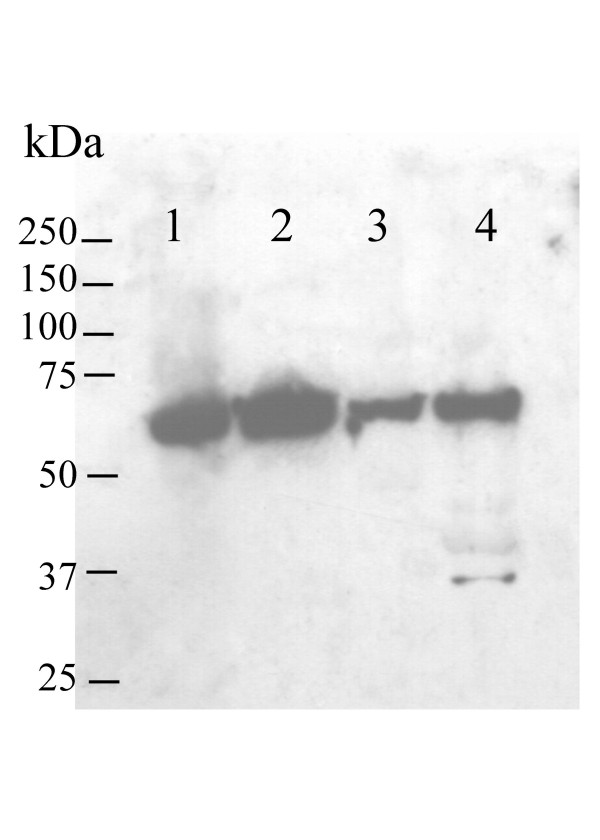
Western blot hybridization using an anti-PPARγ antibody on total protein extracts from 1- human subcutaneous adipose tissue, 2- bovine subcutaneous adipose tissue, 3- bovine brain and 4- bovine skeletal muscle.